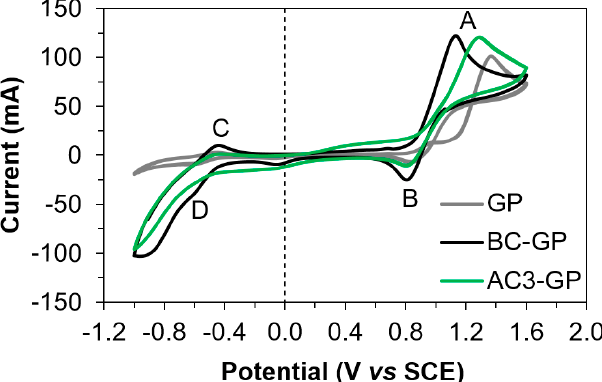
Figure 5. CVs of a pristine GP (grey curve), BC-modified (black curve) and AC3-modified GP (green curve) electrodes in 1.6 M V 3+/4+ containing 4 M H 2 SO 4 . Scan rate: 5 mV s − 1 .